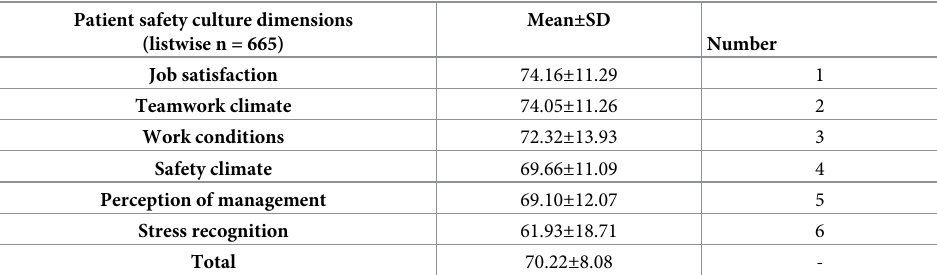
Table 2. Perceptions of respondents on patient safety culture